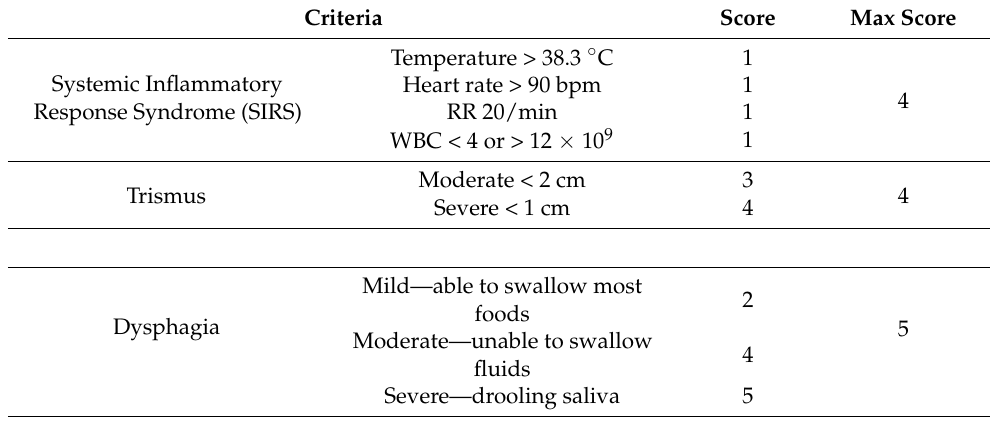
Table 1. The Symptom Severity score (SS) of odontogenic infection developed by Sainuddin et al. [15]. Criteria